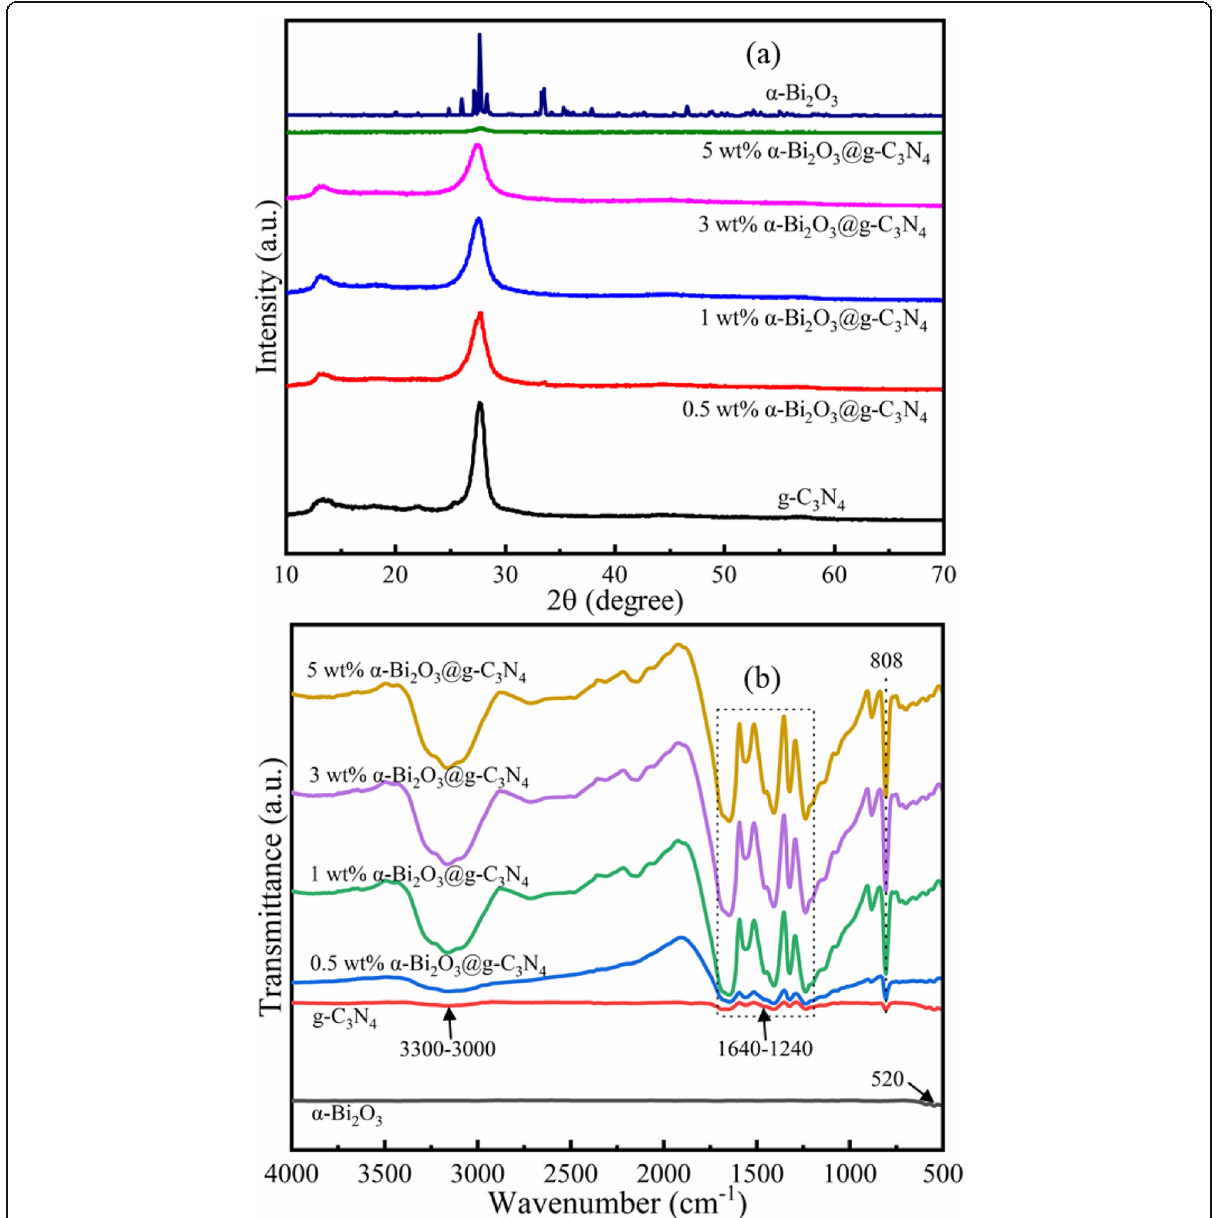
Fig. 4 ( a ) XRD patterns and ( b ) FT-IR spectra of g-C 3 N 4, α -Bi 2 O 3 and the α -Bi 2 O 3 @g-C 3 N 4